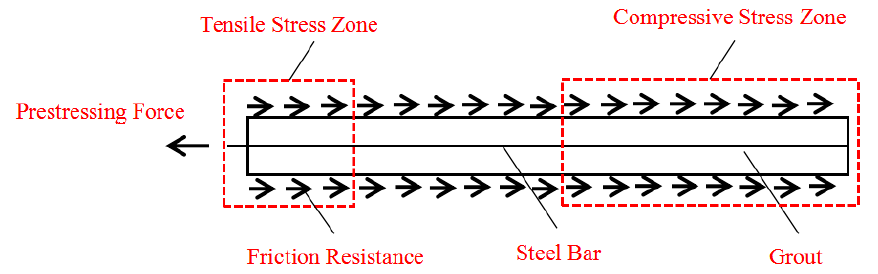
Figure 17. Stress distribution of tensioned anchor after prestressing.